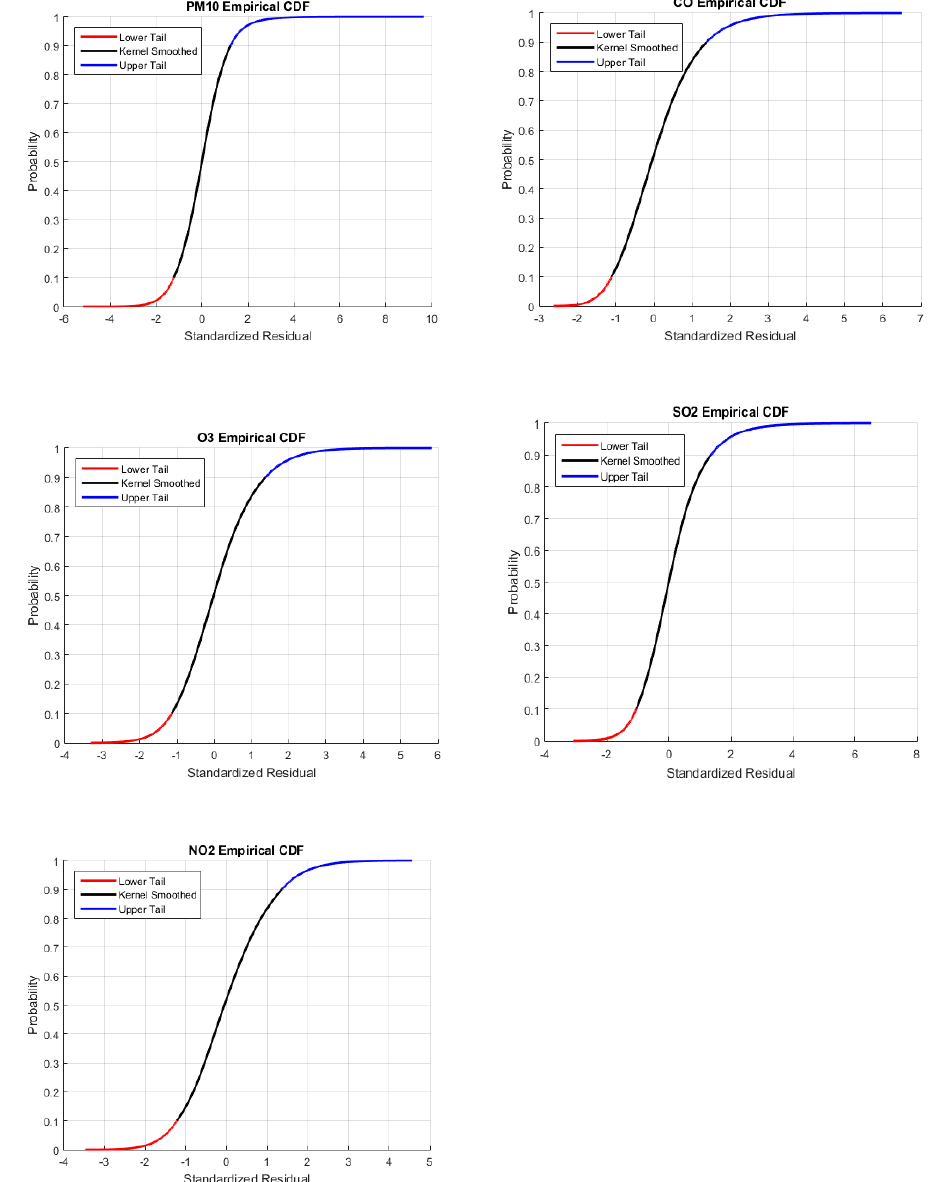
Figure 4. Fitted semi-parametric models for each pollutant variable.